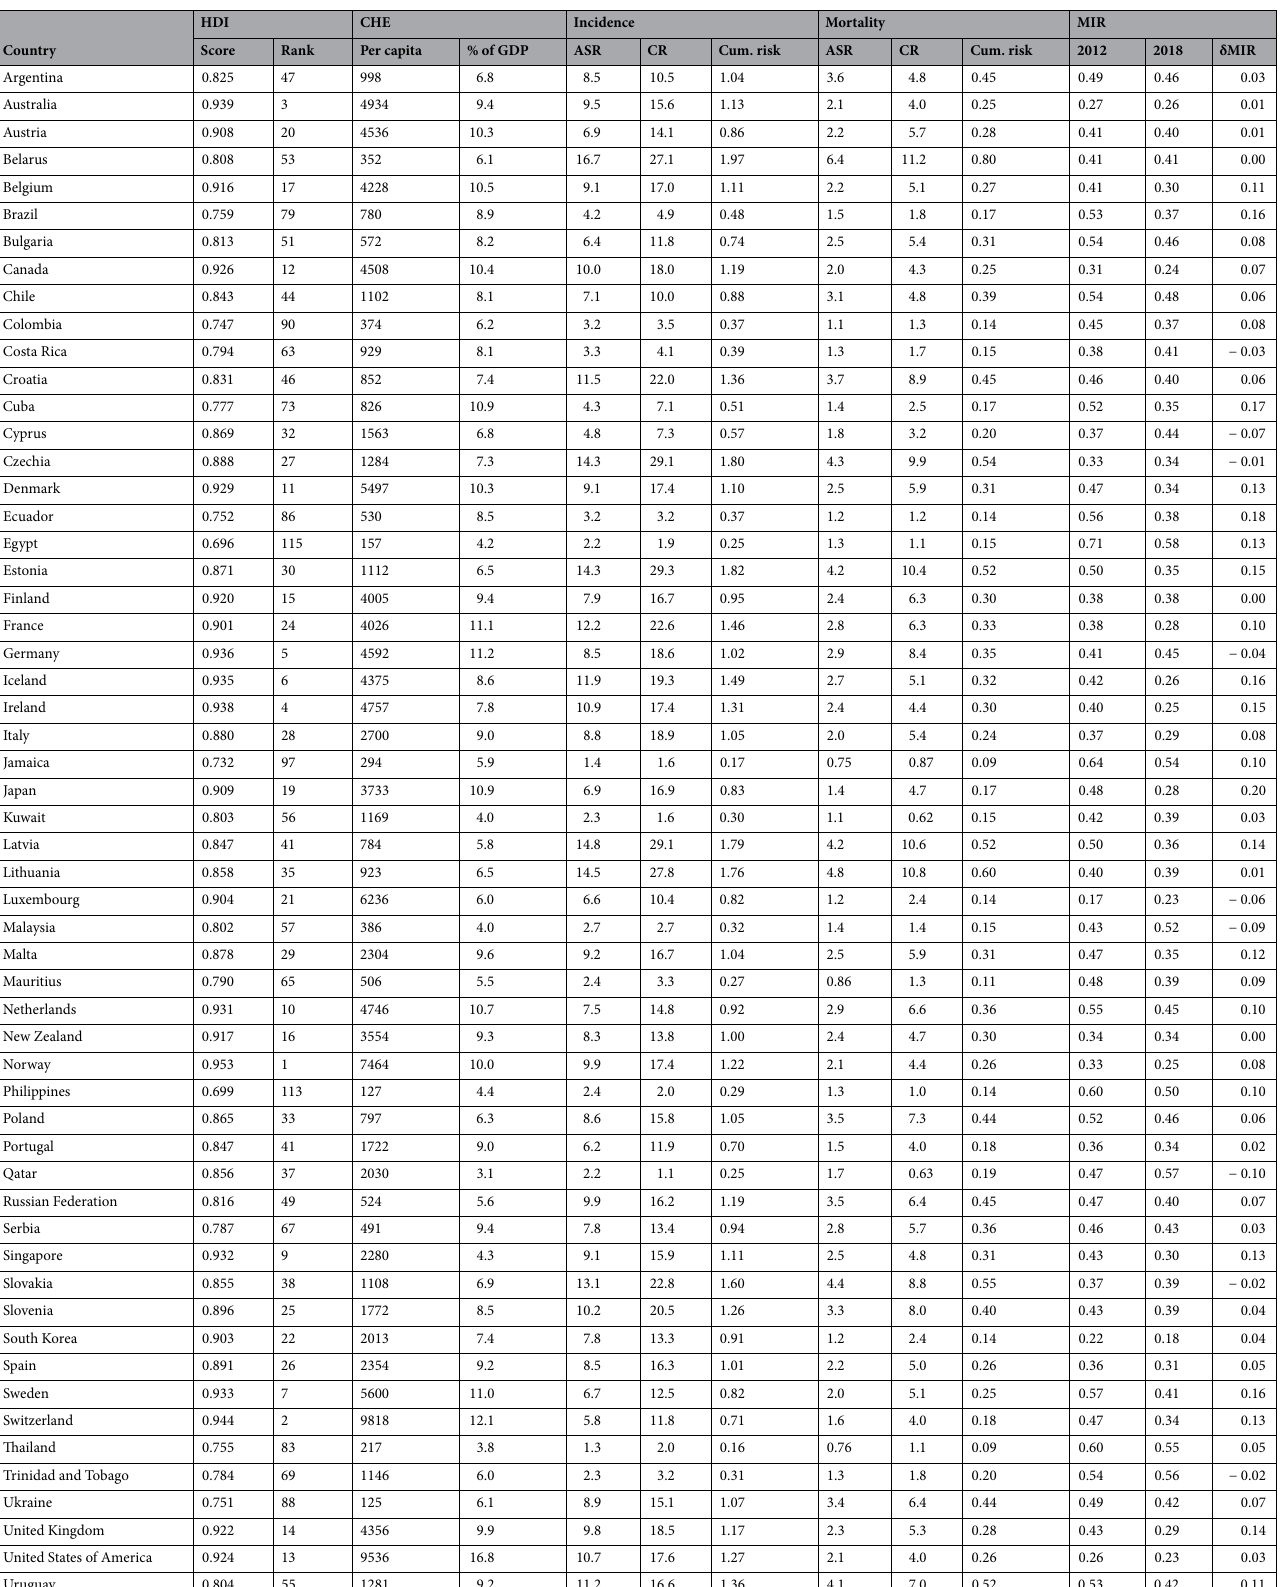
Table 2. Summary of HDI, CHE, cancer incidence, cancer mortality, and MIR in KC of selected countries (N =